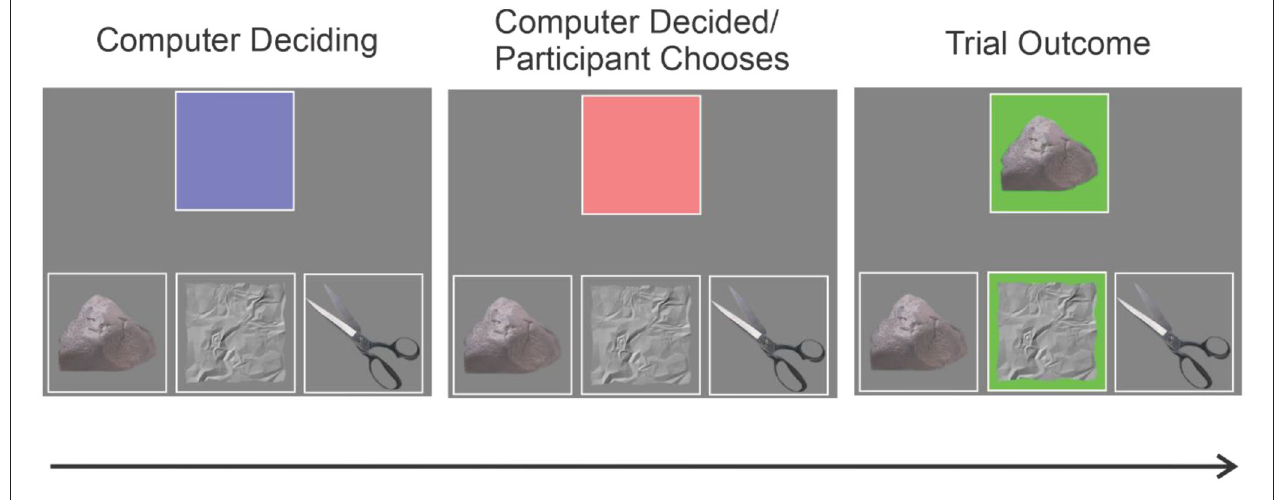
FIGURE 1 | Schematic of a single trial in the “rock, paper, scissors” game. The top square in the center of the screen represented the computer opponent. While “choosing” an option this was colored blue (left) . When the computer had chosen the square changed colors to red indicating that the participant could now choose (middle) . When the participant chose one option, the computer’s choice and the trial outcome were revealed, with a win for the participant indicated by a green background and a loss by a red background (given our task design no ties were possible in this version of the game).